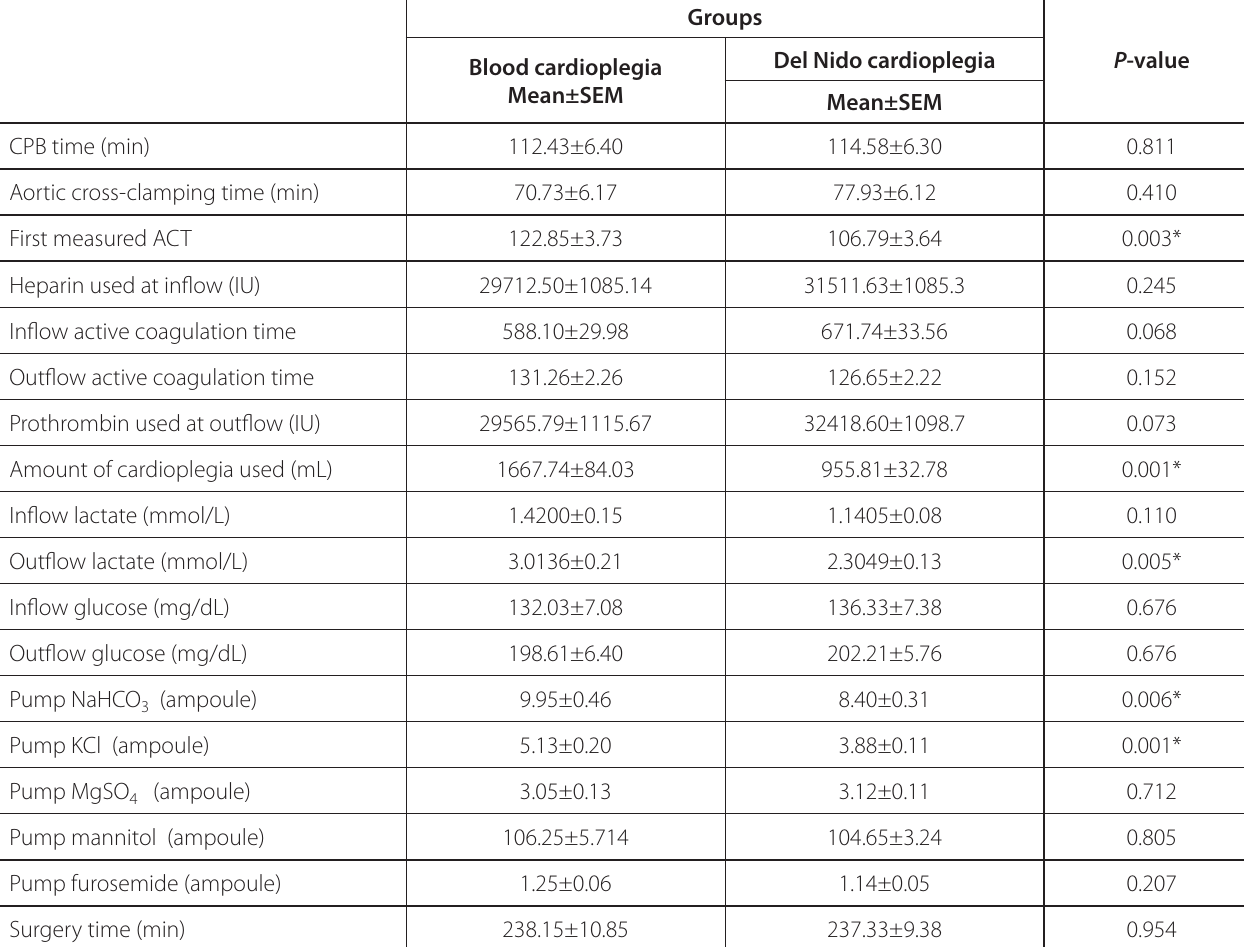
Table 4 . Distribution of operating parameters by type of cardioplegia.